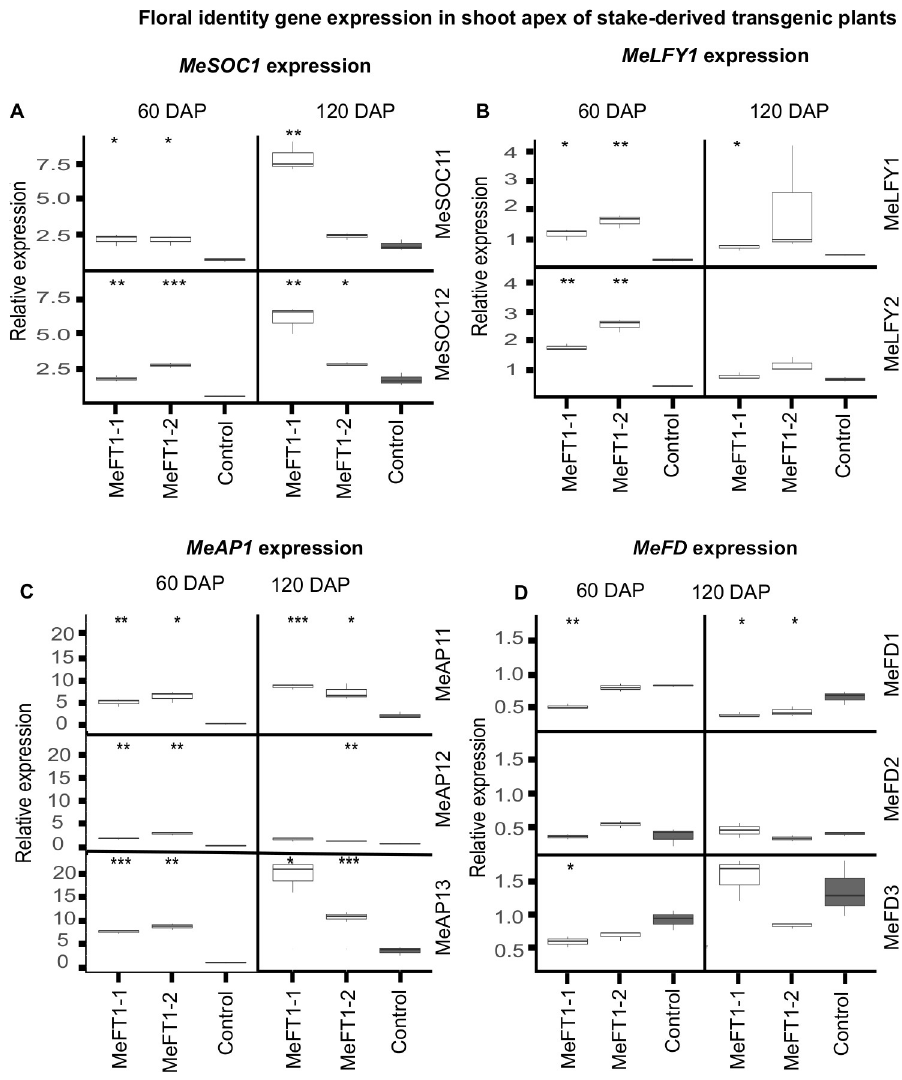
Fig 6. RT-qPCR expression profiling of floral identity genes in shoot apex of transgenic plant lines MeFT1-1, MeFT1-2 and somatic embryo-derived non-transgenic controls. Relative transcript abundance of ( A ) Apetala 1 ( MeAP1 ), ( B ) Leafy ( MeLFY ), ( C ) Flowering Locus D ( MeFD ), ( D ) Suppressor of Expression of Constans 1 ( MeSOC1 ) at 60 and 120 DAP. Data is shown for three independent RT-qPCR reactions each comprising three biological samples and two technical replications. Two-way Student’s t test was performed to compare means of transgenic and non- transgenic embryo derived controls. � P � 0.05; �� P � 0.01; ��� P � 0.001. ggplot2 of R software was used to construct box plots. The middle line in the box shows the median value. Data ranging from smallest value to lower quartile represents lower whisker while values between upper quartile and largest correspond to upper whisker. Values below and above median represent lower and upper quartile of roughly 1.5IQR